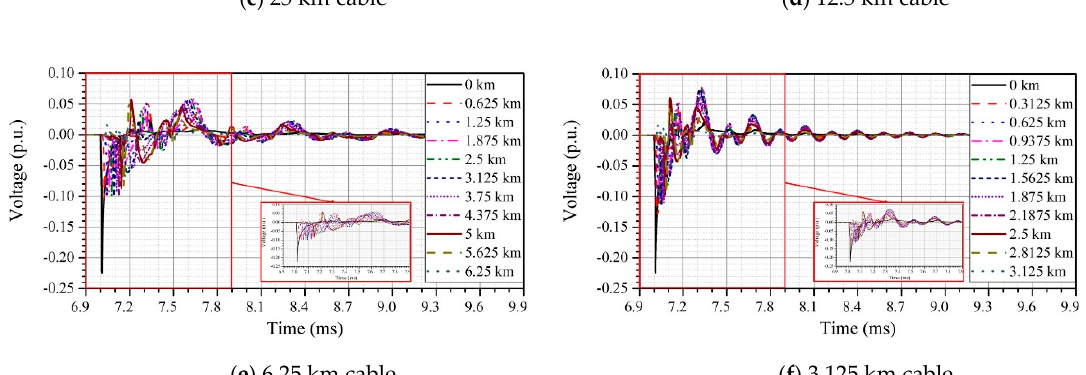
Figure 13. Sheath-ground overvoltage at ten equally spaced intervals along the length of a cable (3.125–100 km).